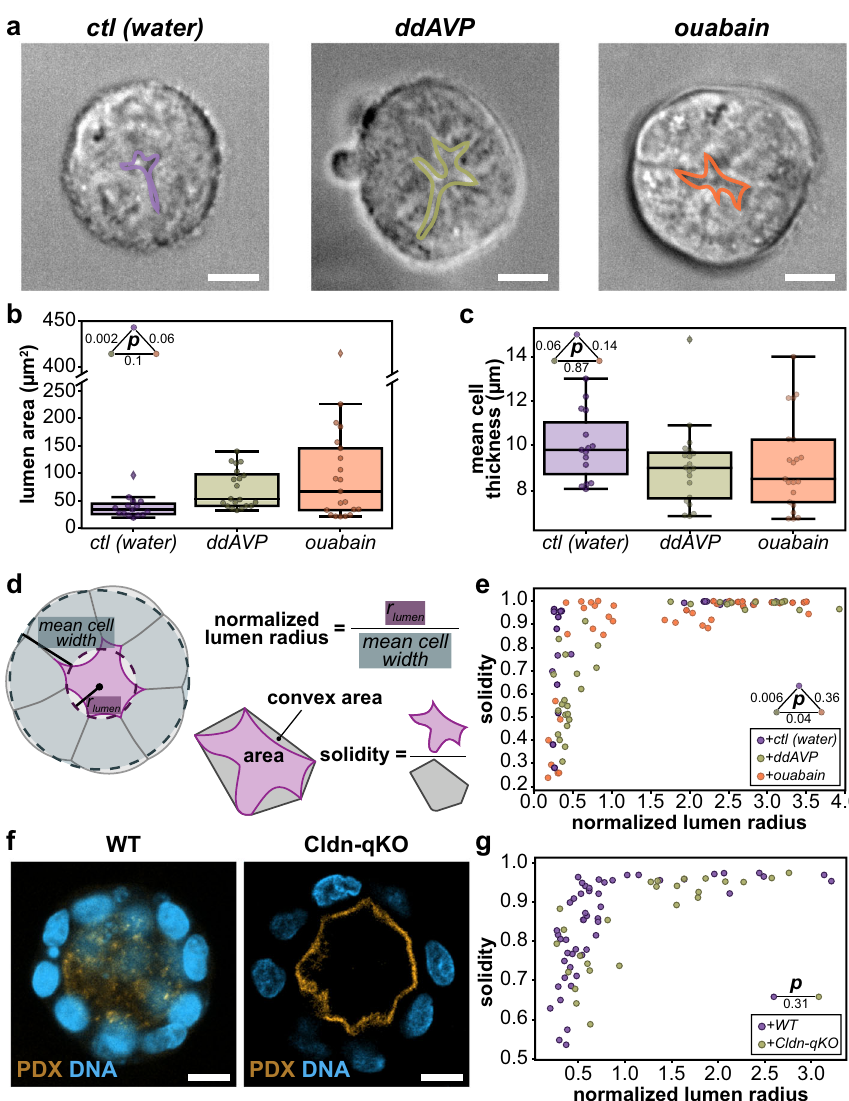
Fig. 2 Manipulation of intraluminal pressure does not signi fi cantly affect lumen shape. a Representative cross-sections of MDCK spheroids grown for 3 days imaged using differential interference contrast treated with vehicle (left), ddAVP (center), or ouabain (right) for 4 h. Lumens are outlined in purple, green, and orange, respectively. b Quanti fi cation of cross-sectional luminal area of MDCK spheroids grown for 3 days in control, ddAVP, and ouabain conditions ( p -values are from two-sided rank-sum test). c Quanti fi cation of mean cross-sectional cell thickness of MDCK spheroids grown for 3 days in control, ddAVP, and ouabain conditions ( p -values are from two-sided rank-sum test). d Schematic describing solidity, a metric that re fl ects surface irregularity, and normalized lumen radius metric. e Solidity of lumens from MDCK spheroids grown for 3 days and 7 days, treated as indicated with vehicle (purple), ddAVP (green), or ouabain (orange) for 4 h as a function normalized lumen radius (ratio of estimated lumen radius determined by lumen volume and mean cell width) ( p -values from two-sided 2D Kolmogorov – Smirnov test). f Representative images of fi xed wildtype (WT, left) and Claudin-quintuple KO (Cldn-qKO, right) MDCK spheroids with lumens immunostained for the apical surface protein podocalyxin (PDX, orange) and DNA (blue) 26 . g Lumen solidity plotted as a function of normalized lumen radius for wildtype lumens (WT, purple), Cldn-qKO lumens (green) ( p -value from two-sided 2D Kolmogorov – Smirnov test). Scale bars are 10 μ m. Box plots in b and c show median, quartiles of dataset, and whiskers extending to maximum and minimum of distributions, excluding outliers (indicated with diamonds). For plots b and c , n = 15, 21, 20 spheroids for control, ddAVP, and ouabain conditions, respectively. For plot e , n = 48, 33, 42 spheroids for control, ddAVP, and ouabain conditions, respectively. For plot g , n = 51, 25 spheroids for WT and Cldn-qKO conditions, respectively. Source data are provided in the Source Data fi